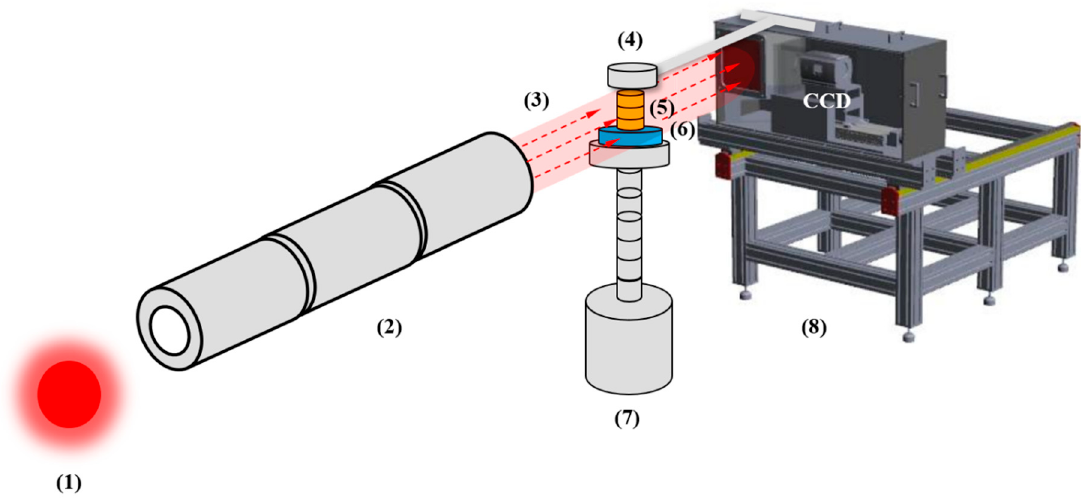
Figure 3. Schematic of experimental arrangement for monitoring water imbibition by neutron radiography: ( 1 ) Neutron source; ( 2 ) Collimator; ( 3 ) Neutron beam; ( 4 ) Specimen holder; ( 5 ) Specimen; ( 6 ) Aluminum container; ( 7 ) Lifting platform; and ( 8 ) Imaging system [34] .